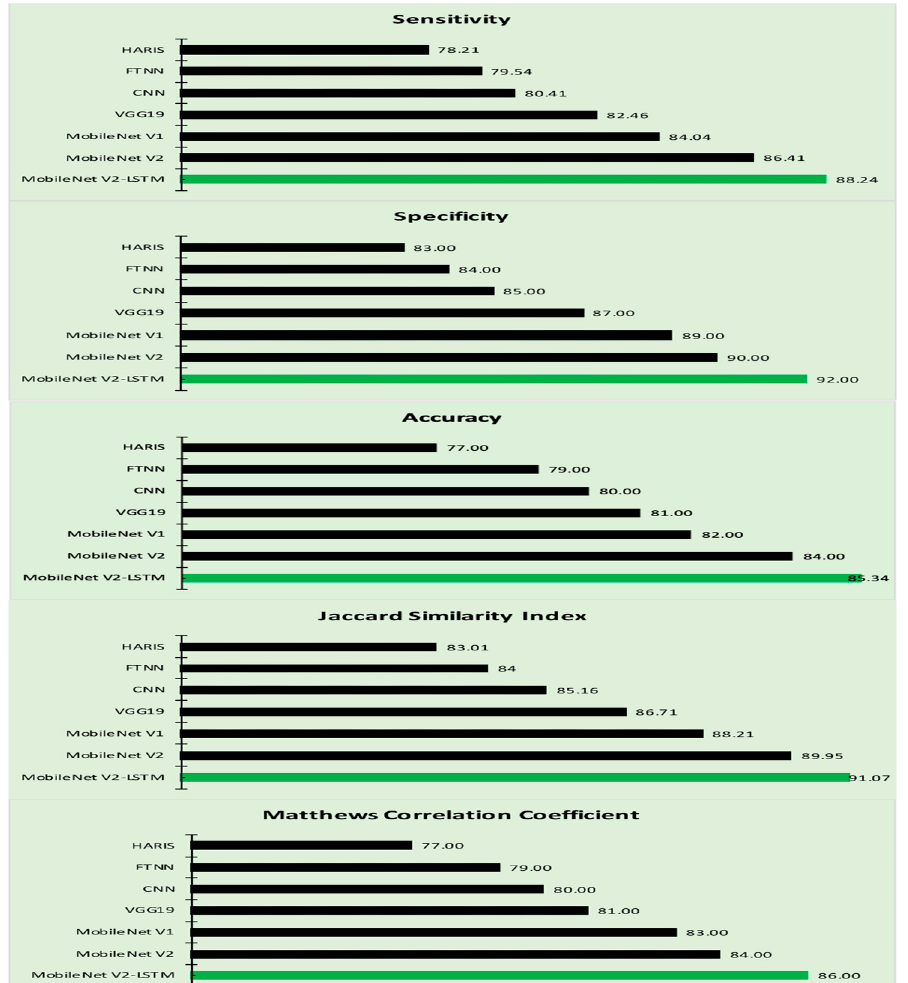
Figure 9. The performance of the MobileNet V2-LSTM model.